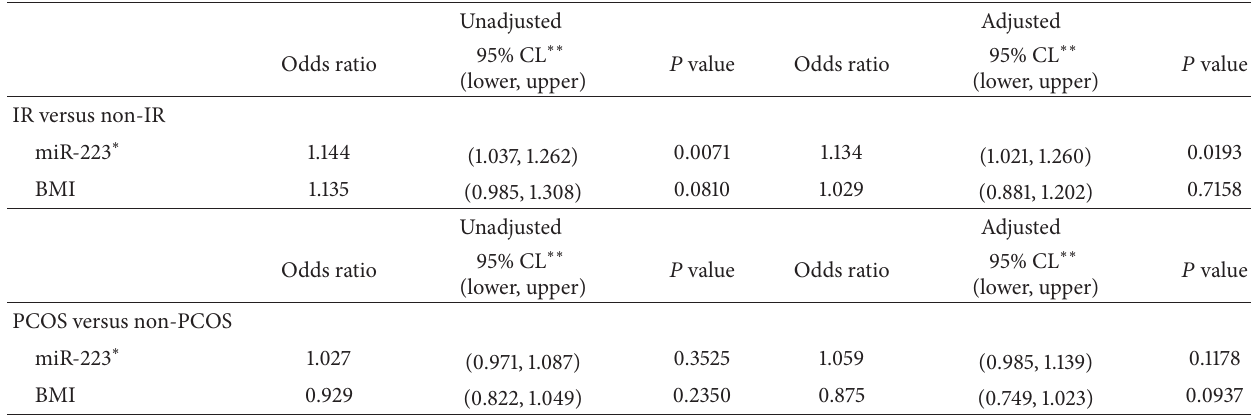
∗ The miR-223 has been multiplied by 100 for the depiction of the odds ratio and confidence limit; the 𝑃 value of the comparisons is not affected. ∗∗ 95% CL is the 95% confidence